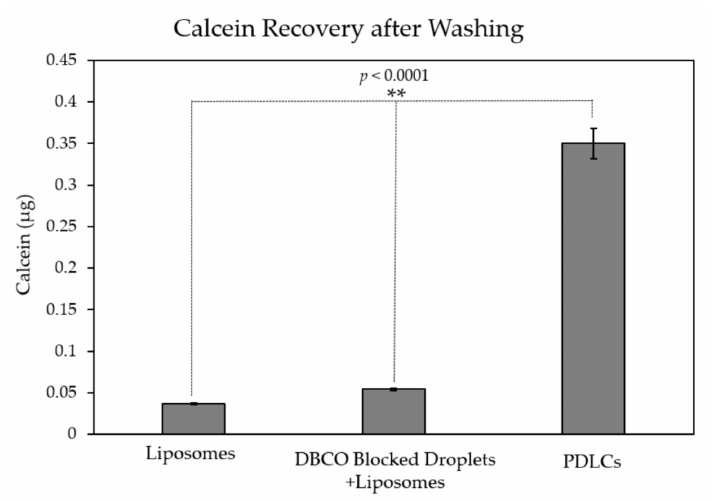
Figure 5. Calcein recovery after washing. Increased calcein recovery is observed in PDLC samples compared to liposomes (** p < 0.0001). DBCO blocking of droplets before clustering shows little non- specific binding indicated by the minimal increase in calcein recovery compared to liposomes